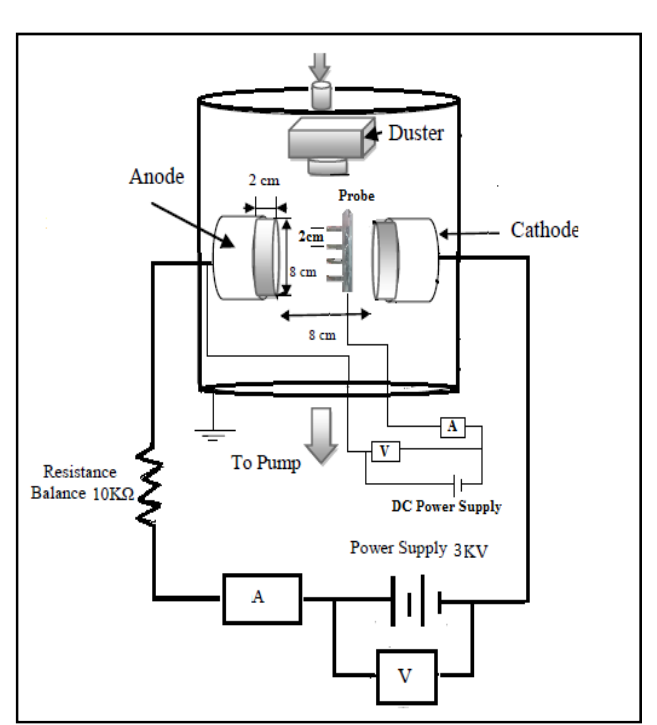
Fig.2: The photograph of the chamber system.